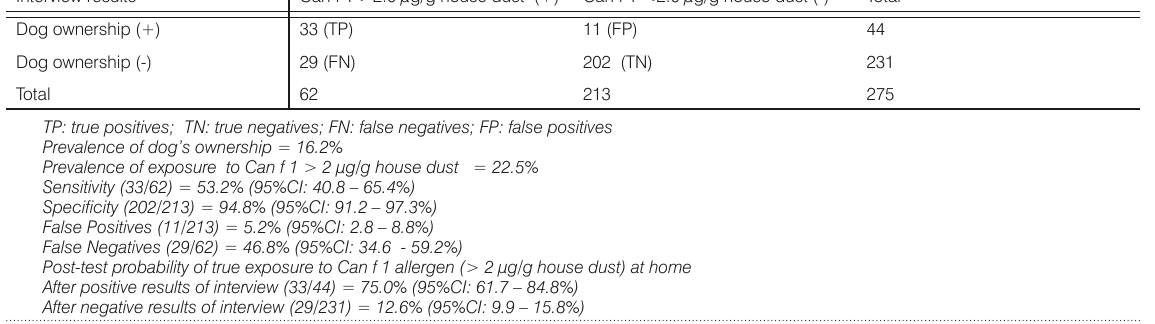
Table 3. Validity of the interview on the ownership of dog over the past 6 months for the prediction of risk exposure level of Can f 1 allergens (concentration >2.0 µg/g house dust) at homes of children. Interview results